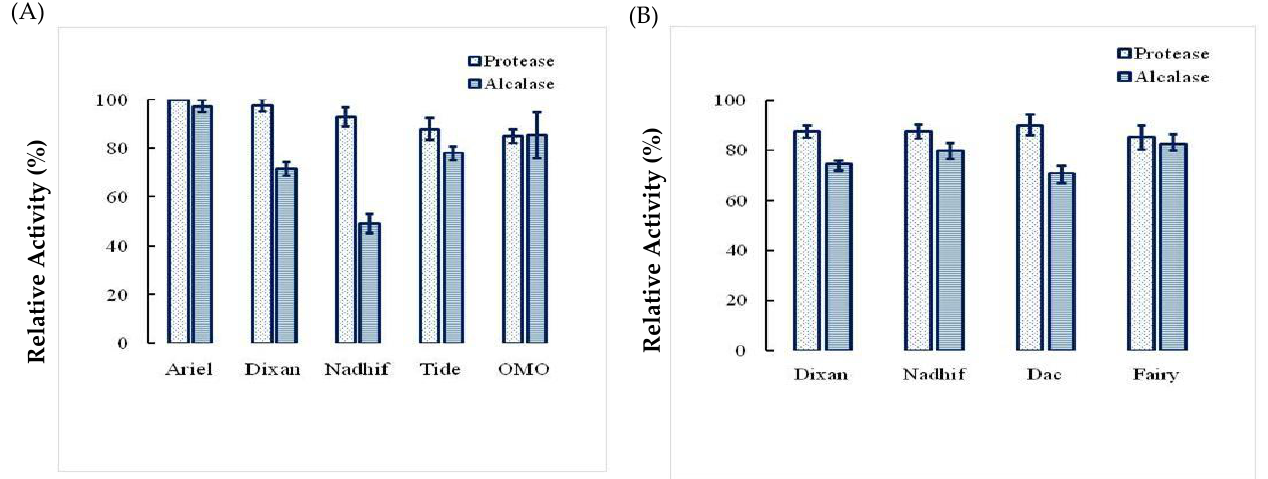
Figure 8. Stability and compatibility of Ba.St.Pr with solid ( A ) and liquid ( B ) commercial laundry detergents compared with commercial Alcalase 2.5 L measured under the same conditions.